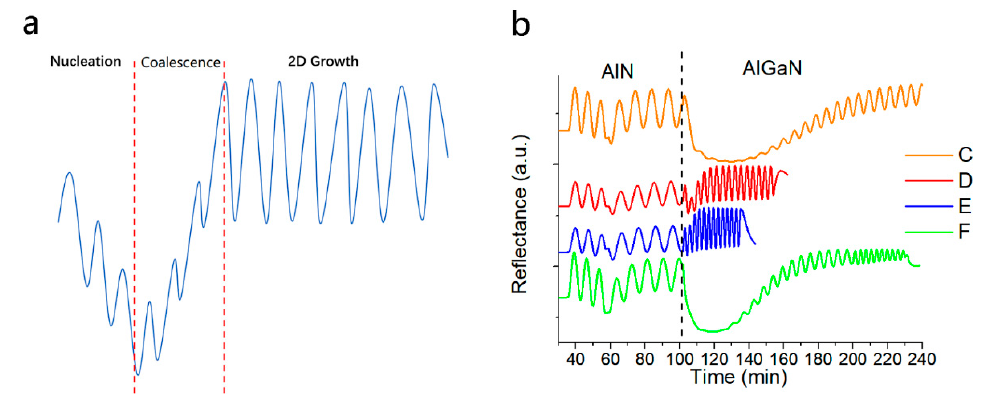
Figure 4. ( a ) The schematic diagram of an in situ reflectance curve divided in 3 parts in the initial stage of AlGaN growth. ( b ) The in situ 633 nm reflectance curves of samples C, D, E, and F.